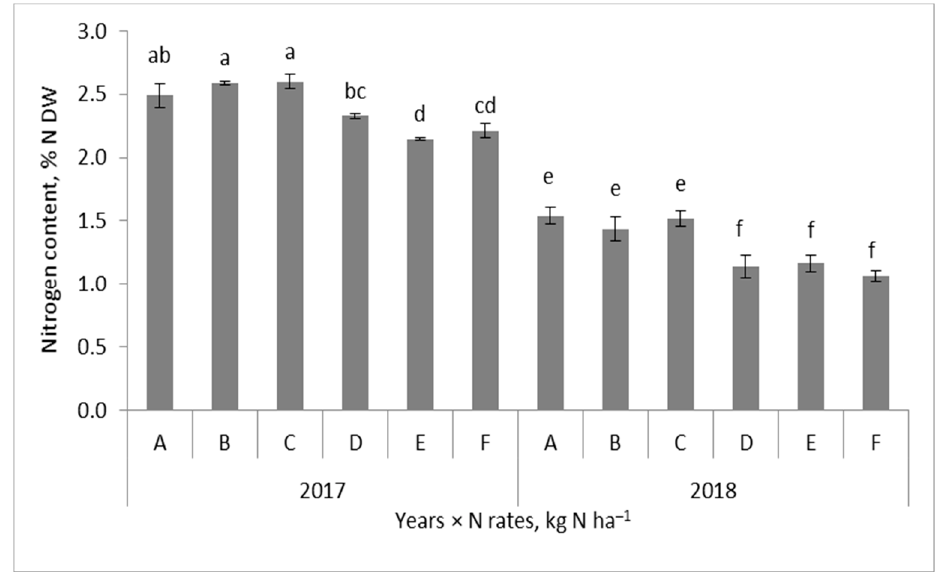
Figure A2. Effect of plant protection methods on the nitrogen content in leaves of winter wheat at BBCH 75. Similar letters indicate a lack of significant differences between experimental treatments using Tukey’s test. The vertical bar in the column is the standard error of the mean.